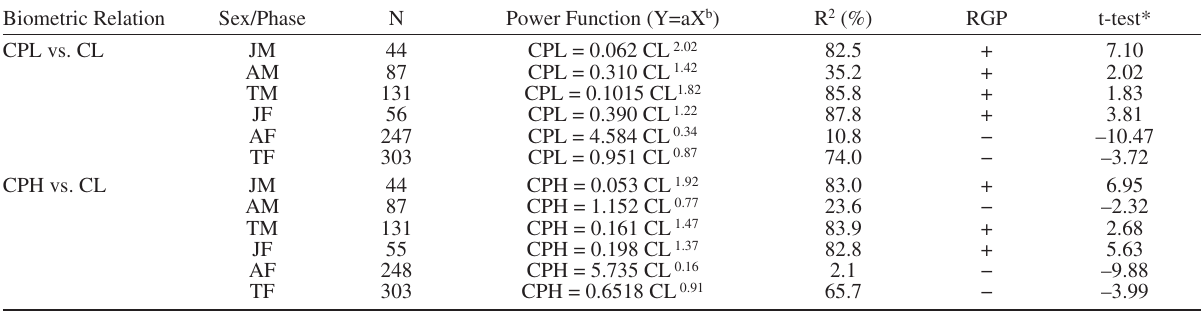
Table 1. – Callichirus major (Say, 1818). Regression analyses and relative growth pattern (RGP) involving variables measured in the carpus of the major cheliped (CPH, height; CPL, length) in relation to body size (CL, carapace length) of each sex and development phase (juvenile and adult). N, number of individuals; JM, juvenile males; AM, adult males; TM, total males; JF, juvenile females; AF, adult females; TF, total females; +, positive allometry; −, negative allometry). *